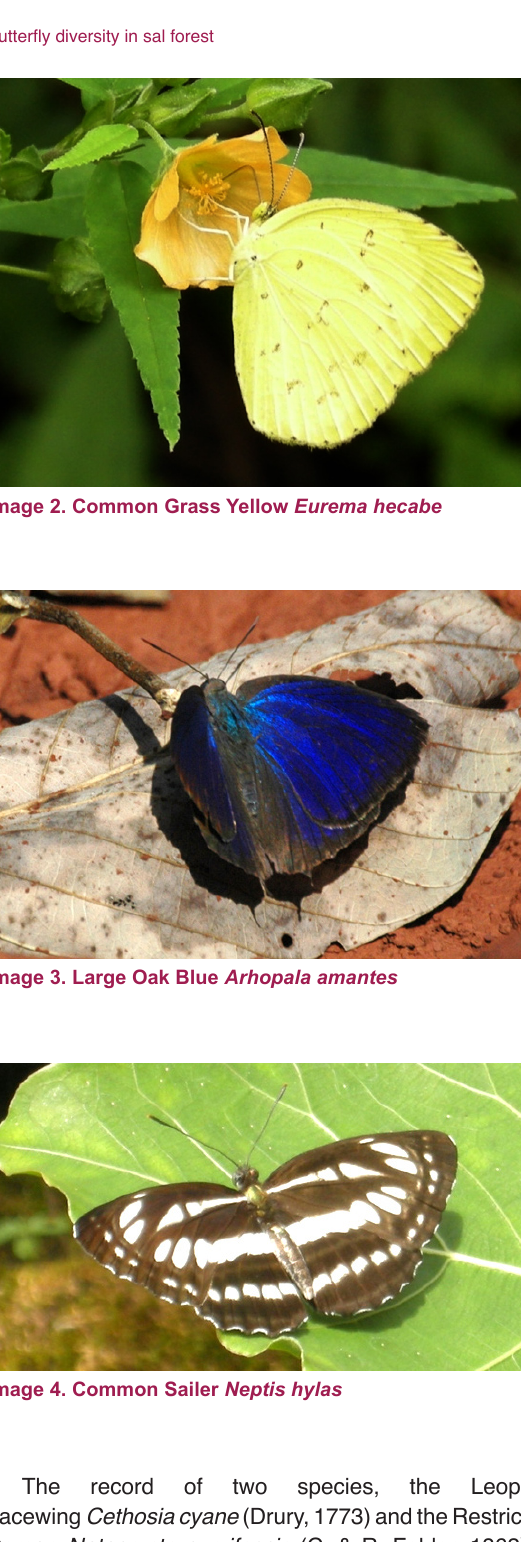
Species Accumulation